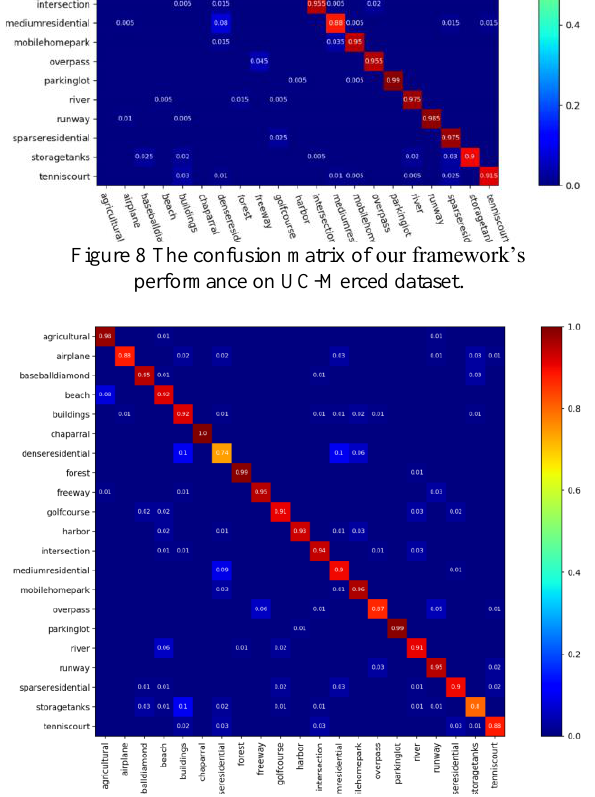
Figure 9 The confusion matrix of SVM classification result on UC-Merced dataset. Figure 10-13 show us the classification performance of